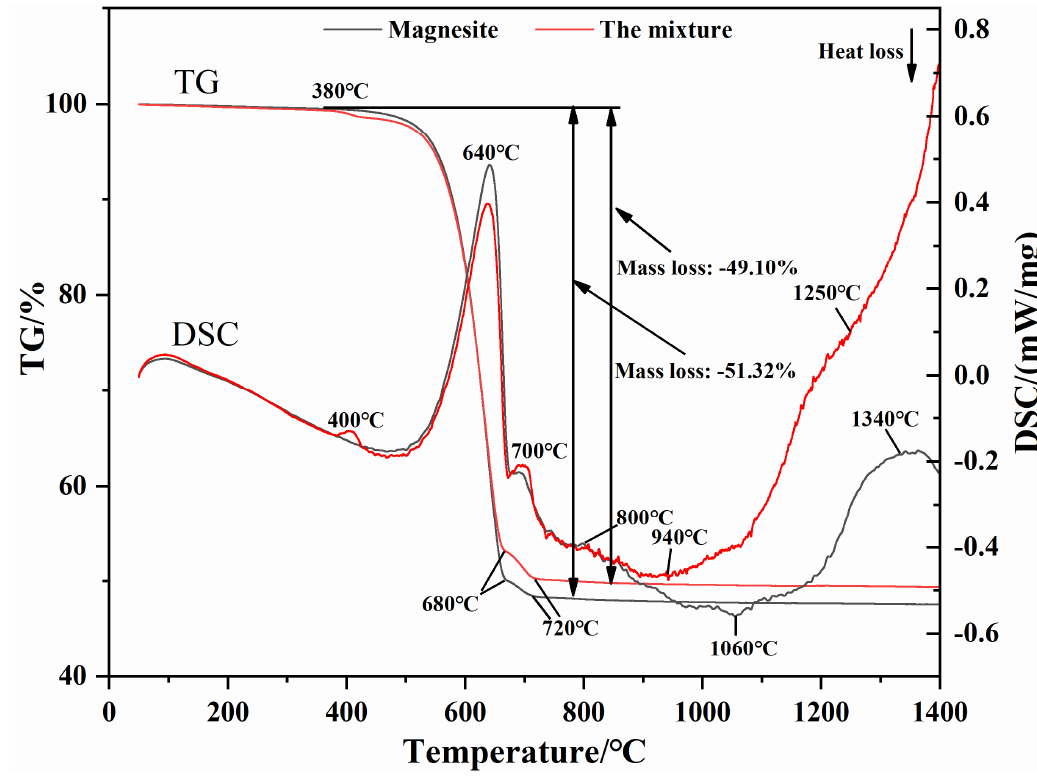
Figure 6. Thermal analysis curves of the magnesite and the mixture.